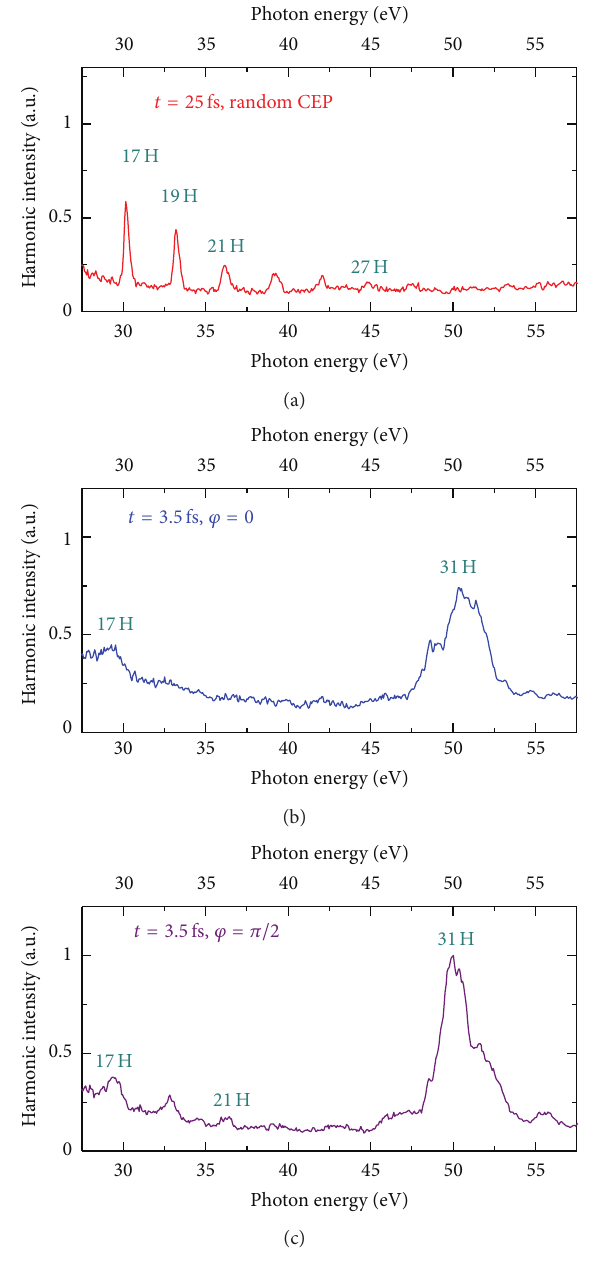
Figure 13: Experimental harmonic spectra generated from man- ganese plasma in the case of the absence of gas in the hollow fiber compressor ( 𝑡 = 25 fs) and random CEP (a), and at 3 bar pressure ( 𝑡 = 3.5 fs) at fixed CEP ( 𝜑 = 0 , (b); 𝜑 = 𝜋/2 , (c)). 𝜑 denotes the carrier envelope phase